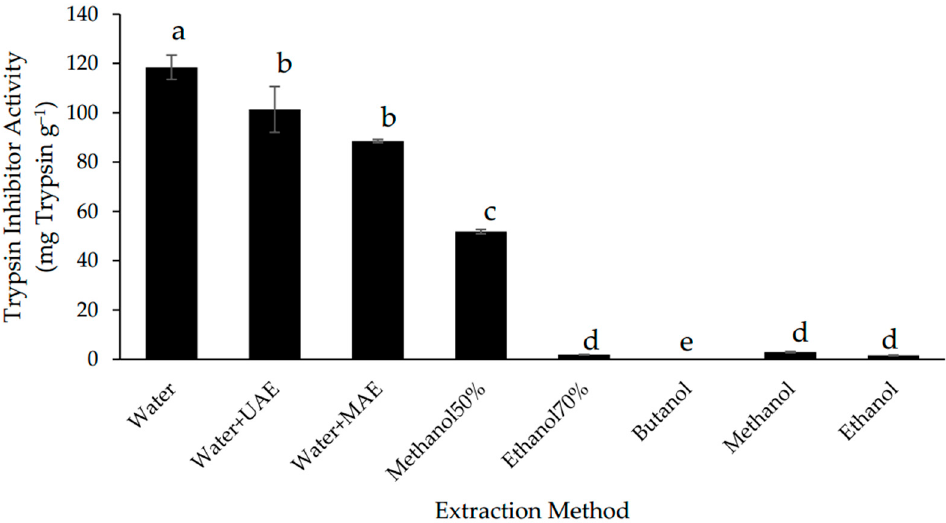
Figure 1. Trypsin inhibitor activity of defatted Gac seed extracts affected by extraction method. The values are the means of three replicates for each extraction. Columns not sharing the same superscript letter are significantly different at p < 0.05.